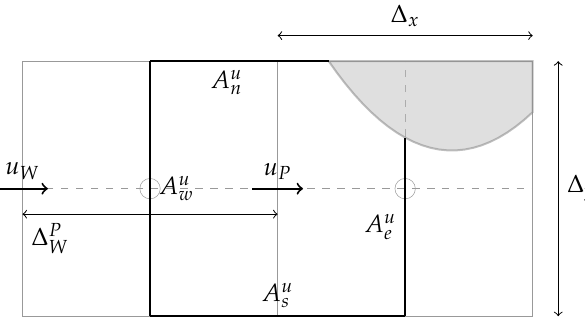
Figure 2. Cut u -cell showing areas and lengths used in the discretization.